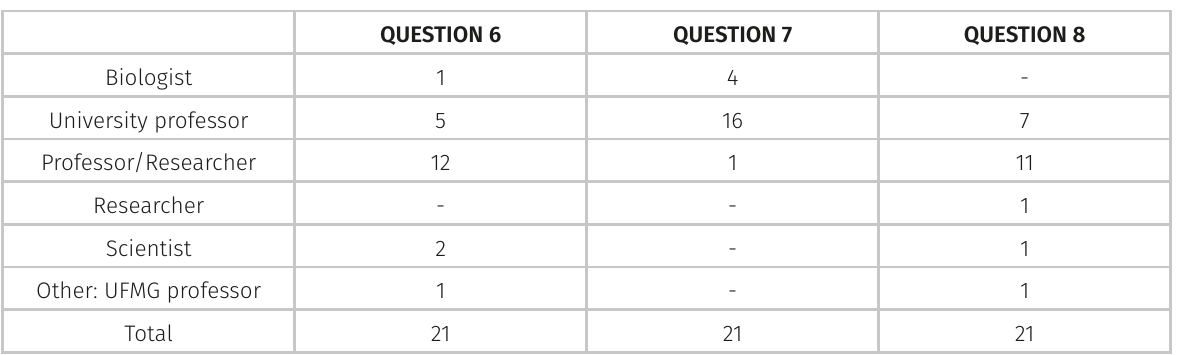
Table II. Frequency of answers for three questions of formal